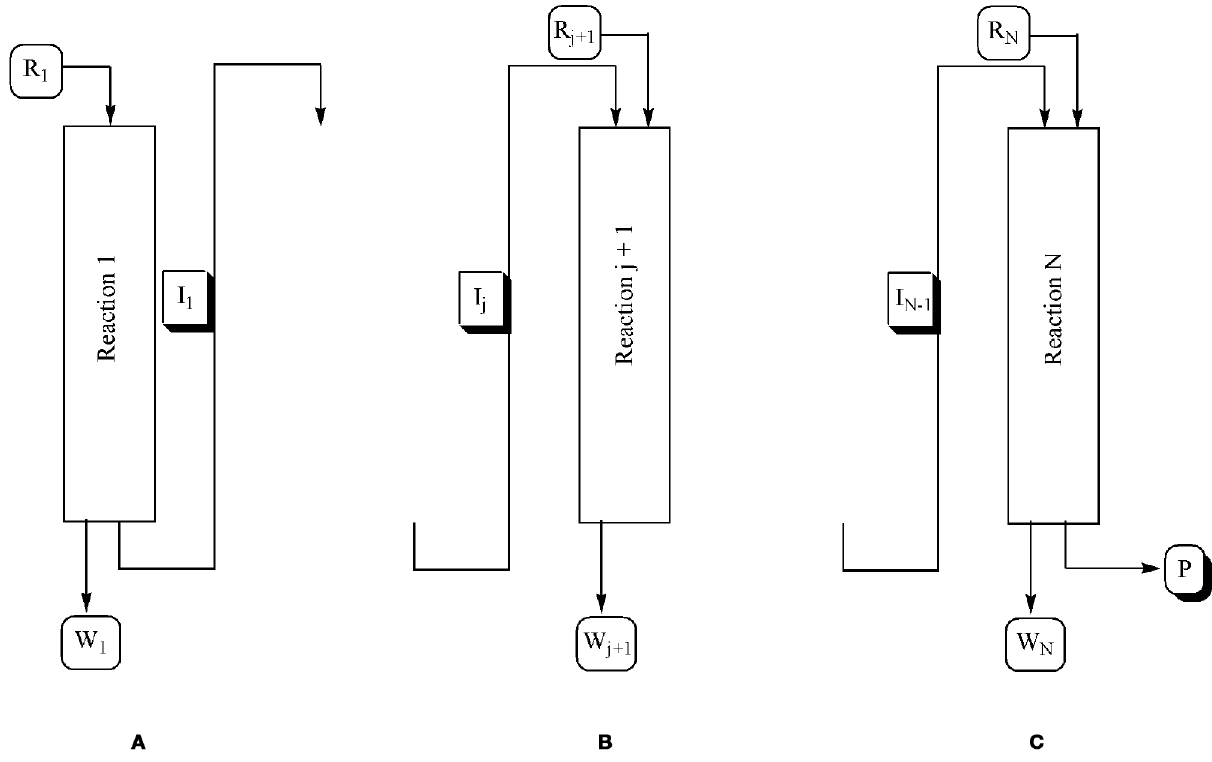
Figure 3: Template used to depict single chemical reactions in the construction of a mass process block diagram: (A) first reaction step; (B) ( j + 1) th reaction step; and (C) last reaction step in an N -step linear synthesis